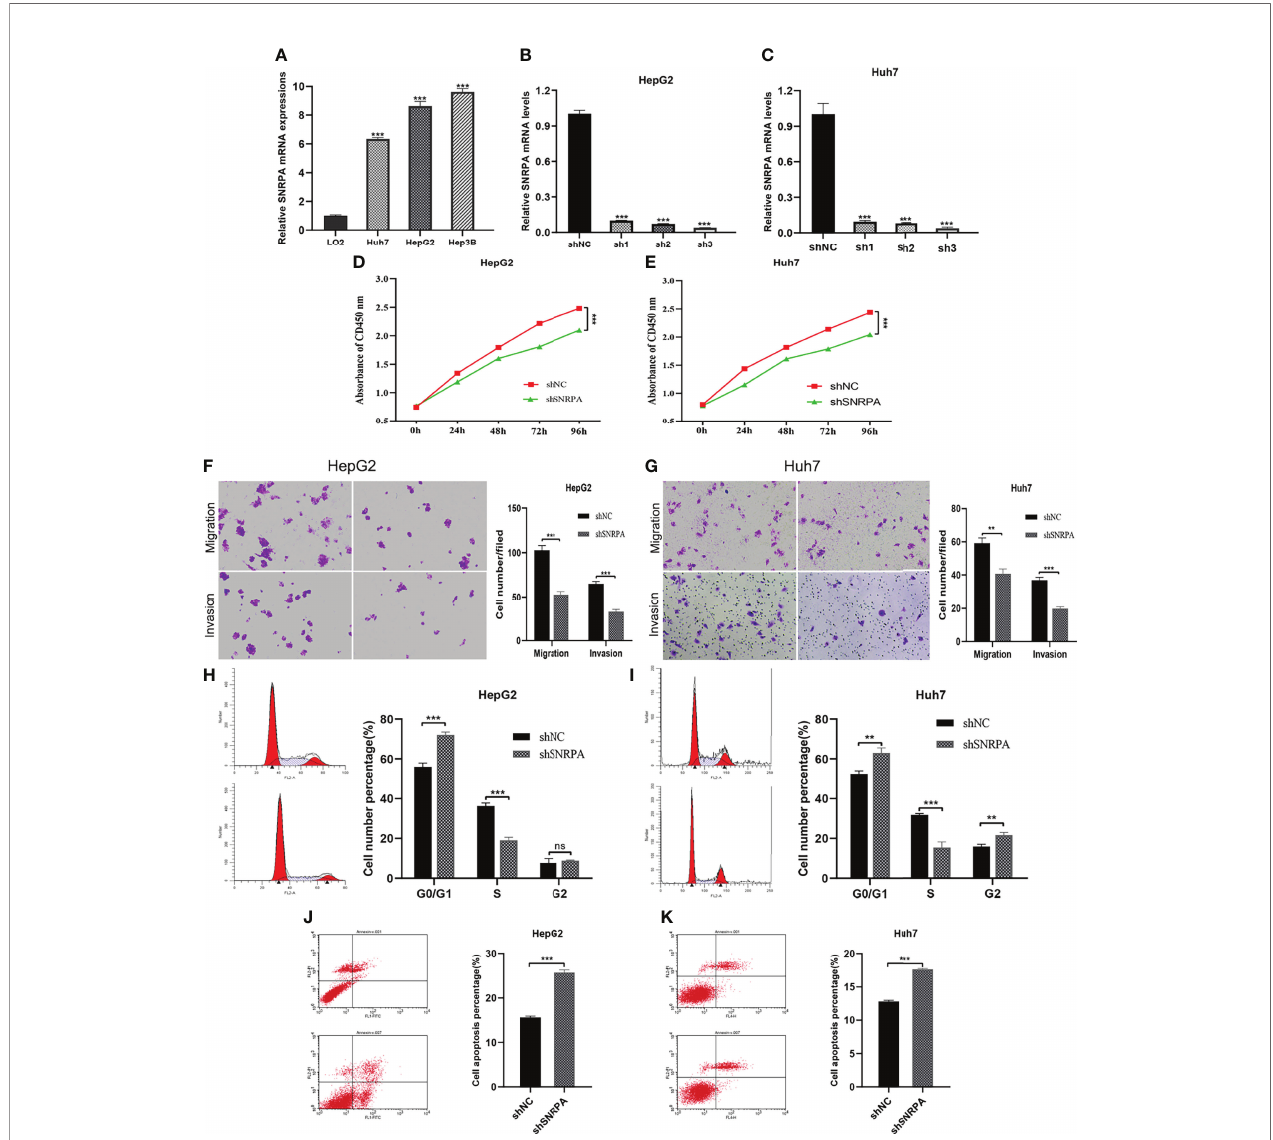
FIGURE 4 | SNRPA regulates the proliferation and migration of HCC cells. (A) SNRPA mRNA expression was greater in HCC cells than in the normal liver cells. (B, C) The shSNRPA with lentiviral transfection were transfected into HepG2 (B) and Huh7 (C) cell lines. (D, E) Cell proliferation of HepG2 (D) and Huh7 (E) cells with shNC and shSNRPA were assessed by CCK-8 assays. (F, G) Representative images and quanti fi ed analysis of transwell assays in HepG2 (F) and Huh7 (G) cells with shNC and shSNRPA. (H, I) Cell cycle distribution of HepG2 (H) and Huh7 (I) cells with shNC and shSNRPA were assessed by fl ow cytometry. (J, K) Cell apoptosis rate of HepG2 (J) and Huh7 (K) cells with shNC and shSNRPA were determined by fl ow cytometry. ** P < 0.01, *** P < 0.001. ns: no statistically signi fi